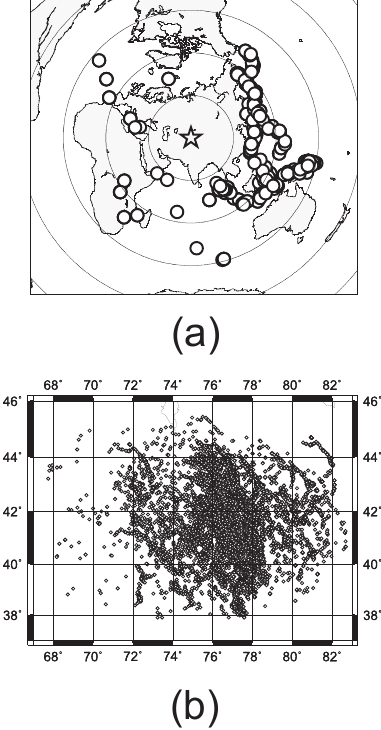
Figure 2. Epicenters of seismic events (a) and projections of pierc- ing points at a depth of 535km (b)